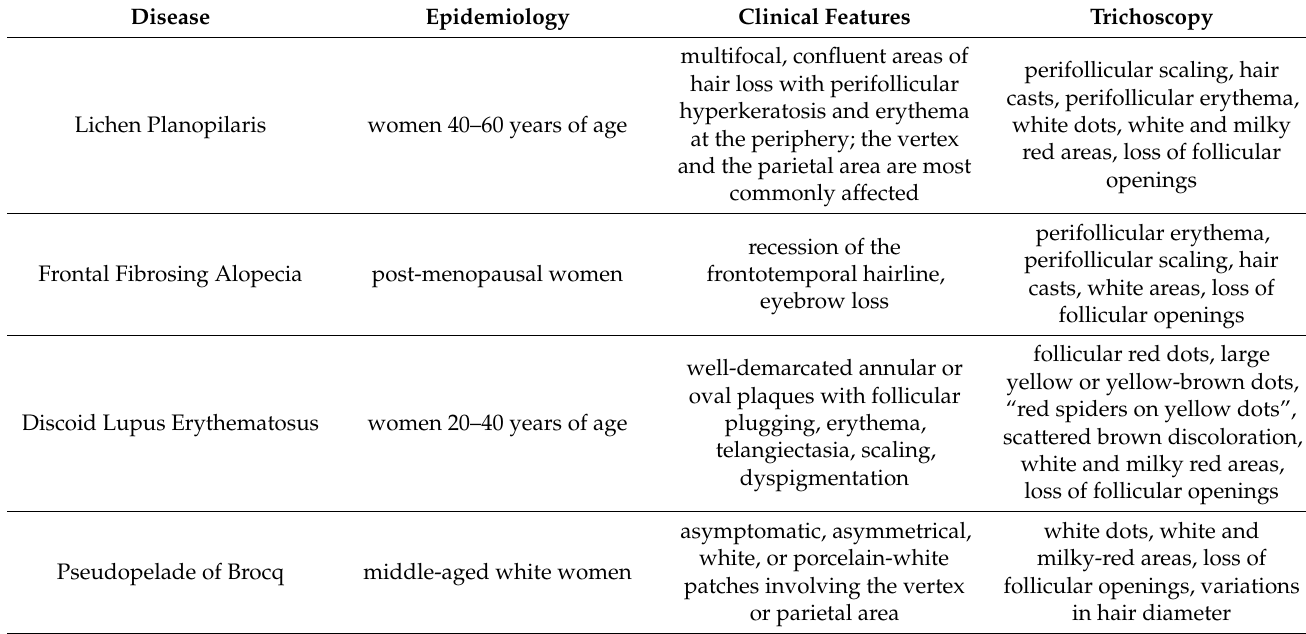
Table 5. The clinical and trichoscopic characteristic of cicatricial alopecias associated with pili